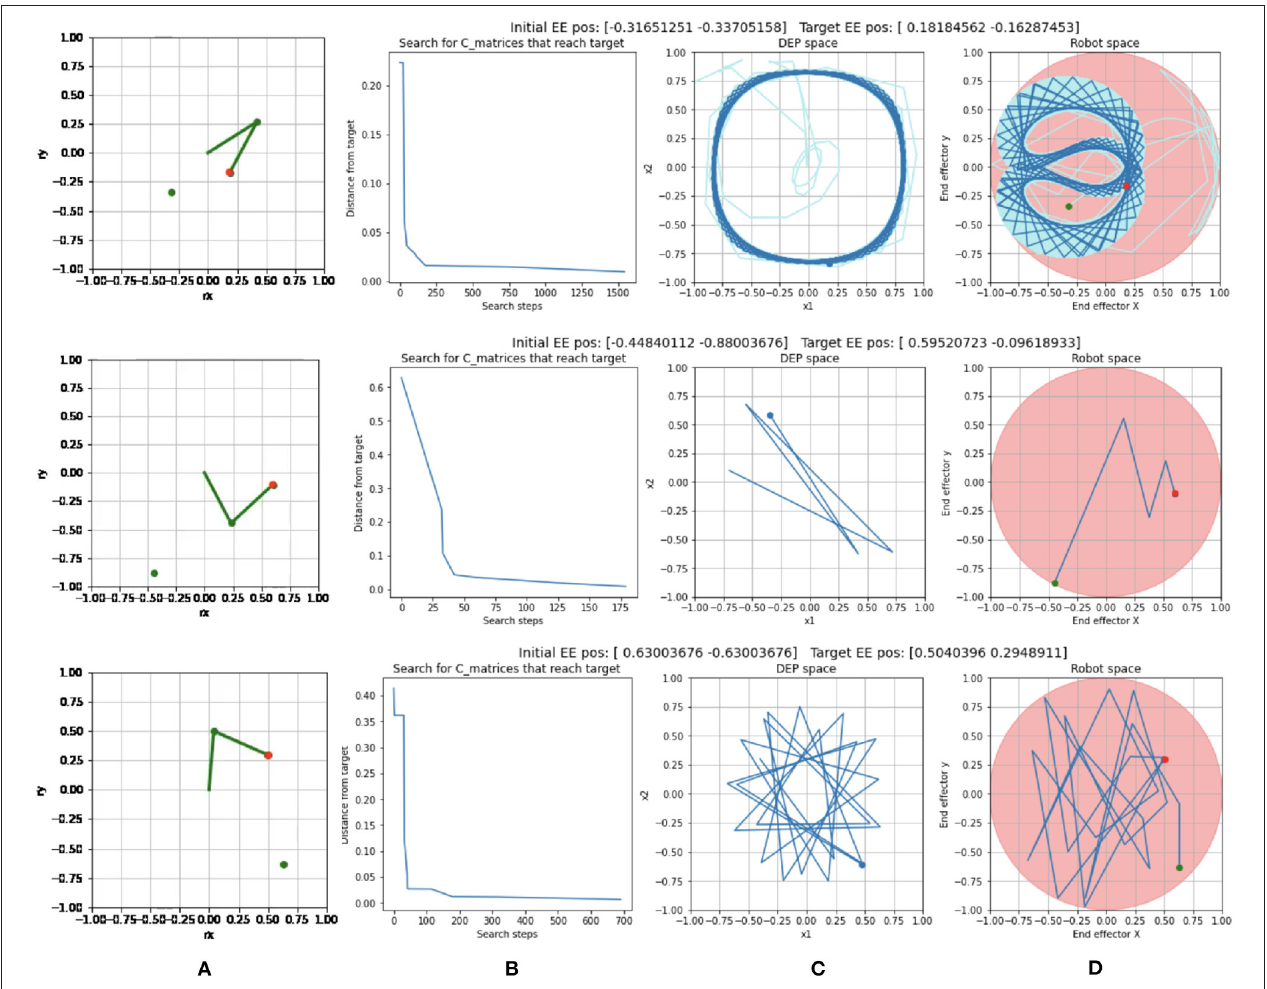
FIGURE 5 | Examples of Reaching trials with: (A) different end effector start positions (green dot) and target positions (red dot). (B) The progress of the search for a solution C matrix. (C) The solution trajectory in DEP space for the successful trial. (D) The solution trajectory in robot space for the successful trial. The most recent positions are shown in dark blue while the early part of the trajectory is in light